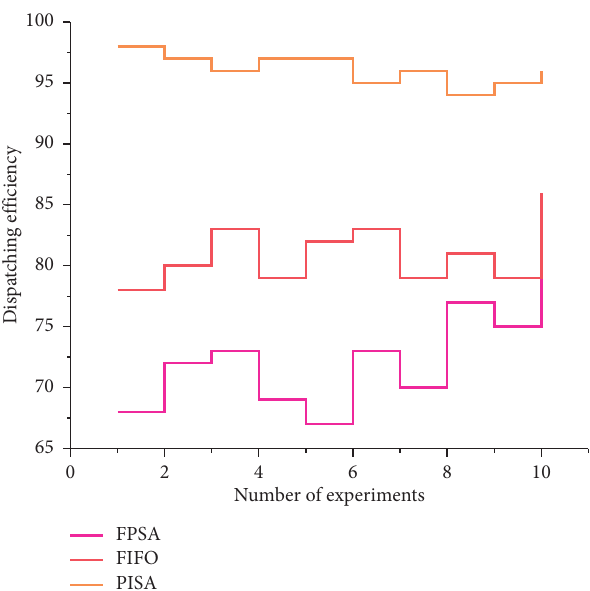
Figure 10: Execution cost comparison